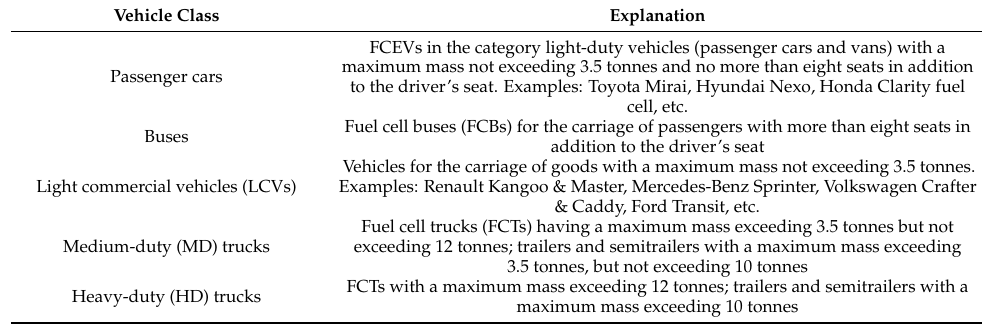
Table 1. Vehicle classes used to assess the number of fuel cell vehicles (FCVs) in each